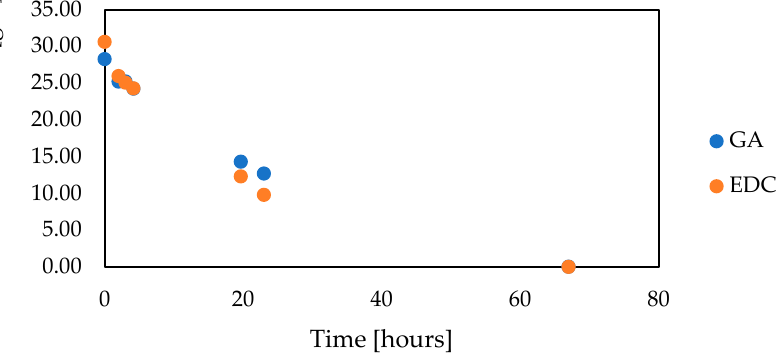
Figure 3. Glucose decomposition by co-encapsulated glucose oxidase and catalase without exogenous aeration (capsules volume 3 mL, total volume 10 mL, glucose oxidase concentration 1.05 g/L, catalase concentration 0.09 g/L, 0.1 M HEPES buffer pH 6.6, 12 ◦ C, CaCO 3 4 g/L, without exogenous aeration).